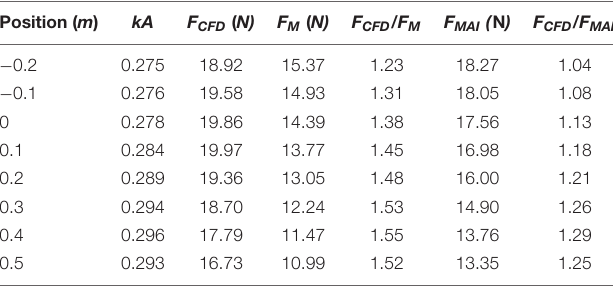
TABLE 3 | Maximum inline forces on cylinders at different positions.